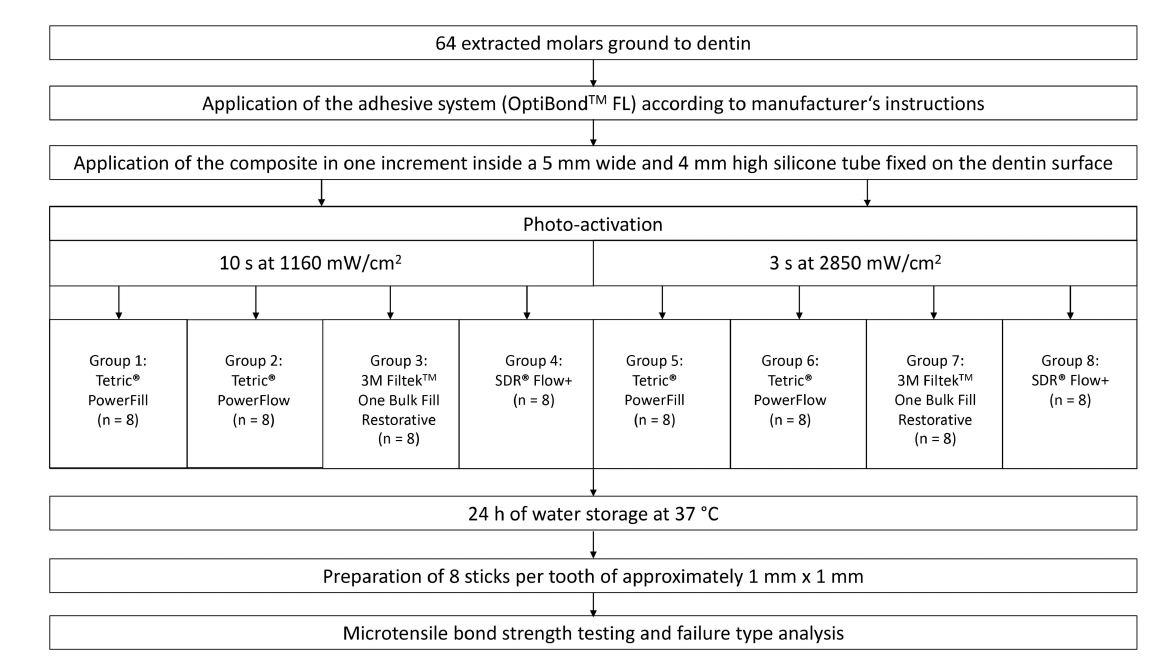
Figure 1. Flowchart of the study. Table 1. Manufacturers’ information about the resin composite materials used in this